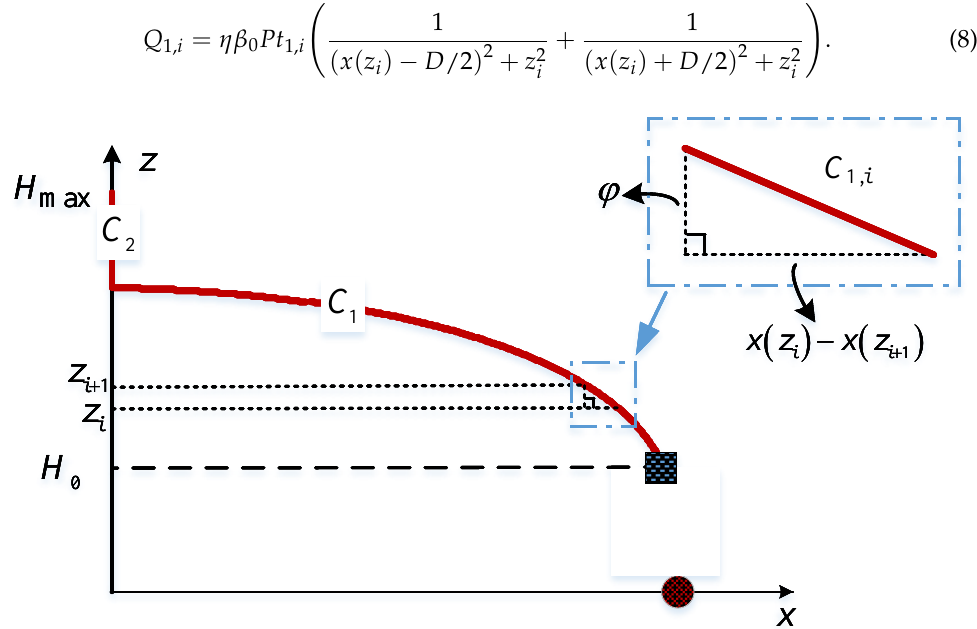
Figure 4. Calculating the received energy with